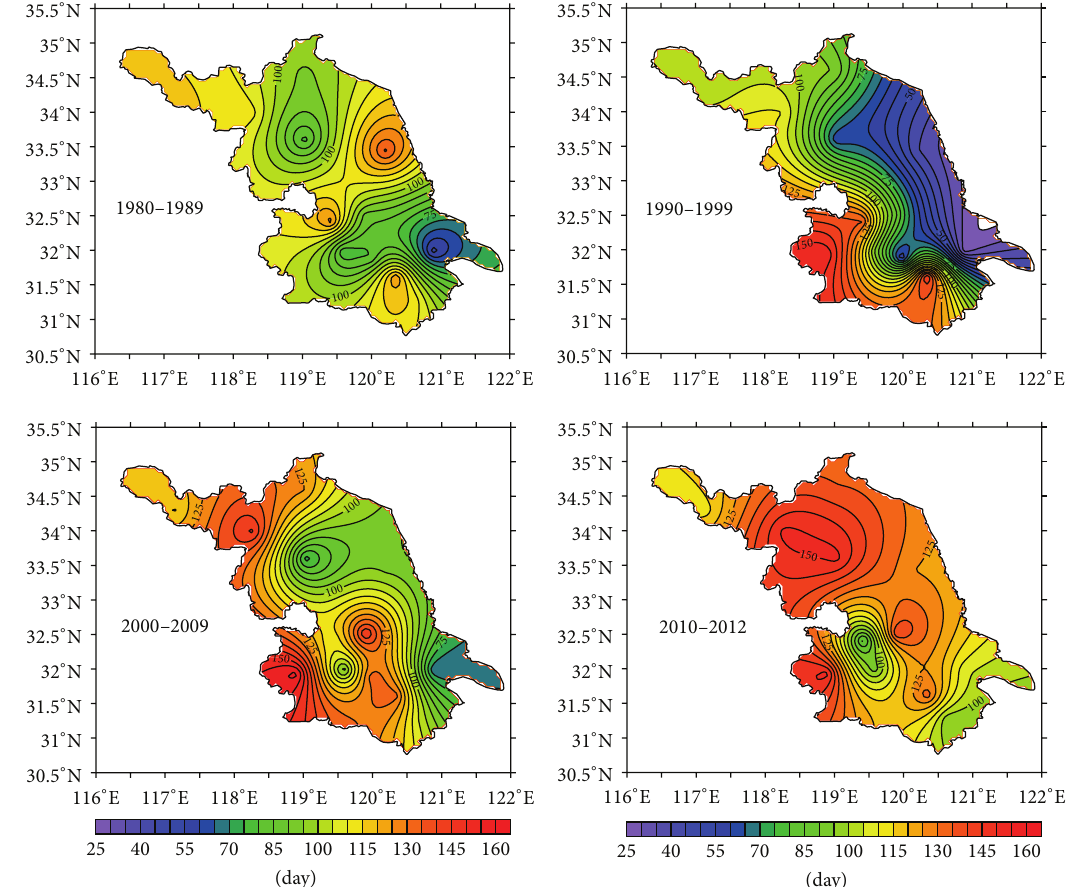
Figure 1: Space-time distribution of hazy day from 1980 to 2012 (yearly average).